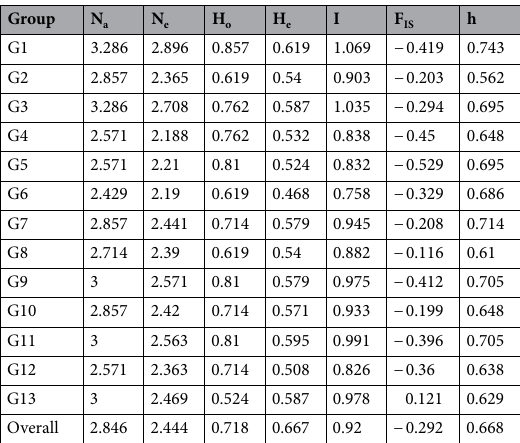
Table 1. Genetic diversity and diversity indices of yellow-legged hornets ( Vespa velutina nigrithorax ) based on seven nuclear microsatellite loci estimated in 13 sampling sites: mean number of alleles (N A ), number of effective alleles (N E ), observed (H O ) and expected (H E ) heterozygosity, Shannon’s information index (I), inbreeding coefficient relative to the population (F IS ), and molecular diversity (h).